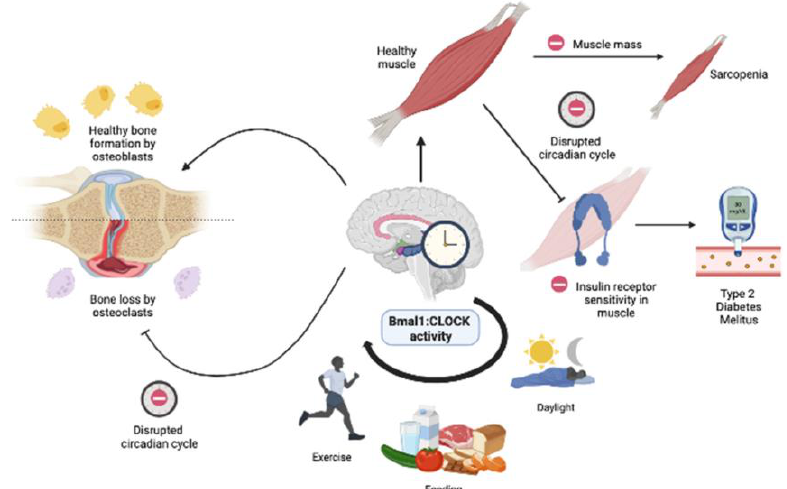
Figure 3. Simplified diagram illustrating the musculoskeletal changes with circadian disruption. The Bmal1: CLOCK activity is regulated by exercise, diet, and sleep quality. Disruptions in the Bmal1: CLOCK can compromise healthy skeletal and muscle function. In healthy muscles, circadian disruption can lead to decreased muscle mass and insulin resistance, which is linked to sarcopenia and type 2 diabetes mellitus, respectively. In bones, circadian disruption shows increased differentiation in osteoclasts leading to bone loss.